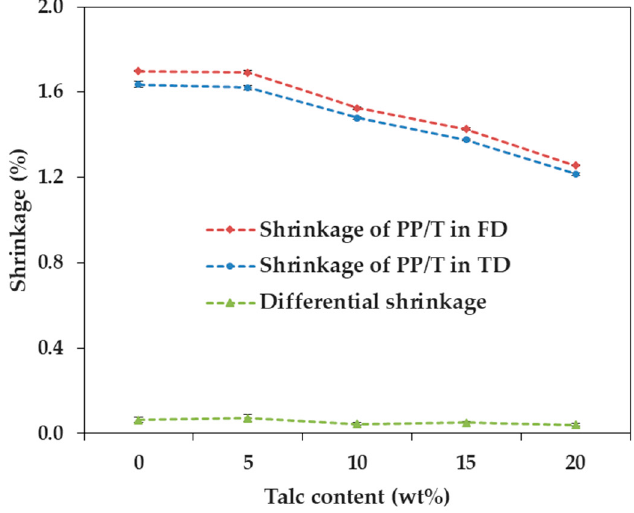
Figure 6. Shrinkage of PP/T as a function of talc content.